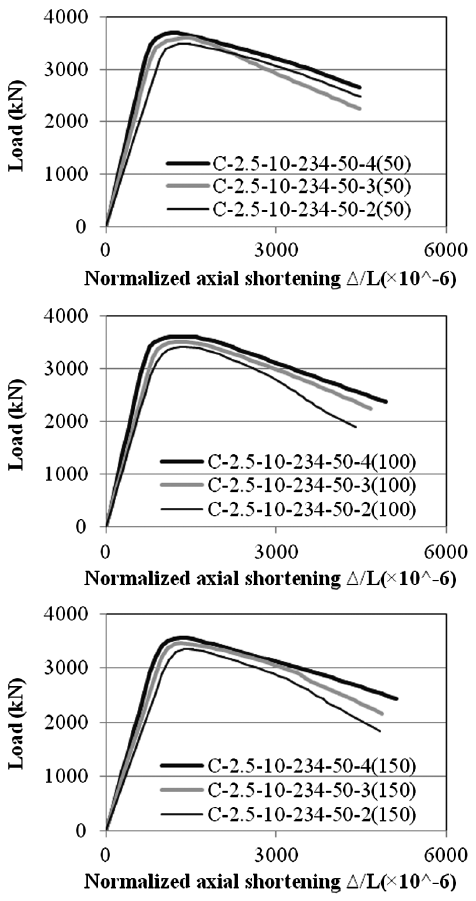
Fig. 9. Effects of number of bar stiffeners on ultimate axial load capacity